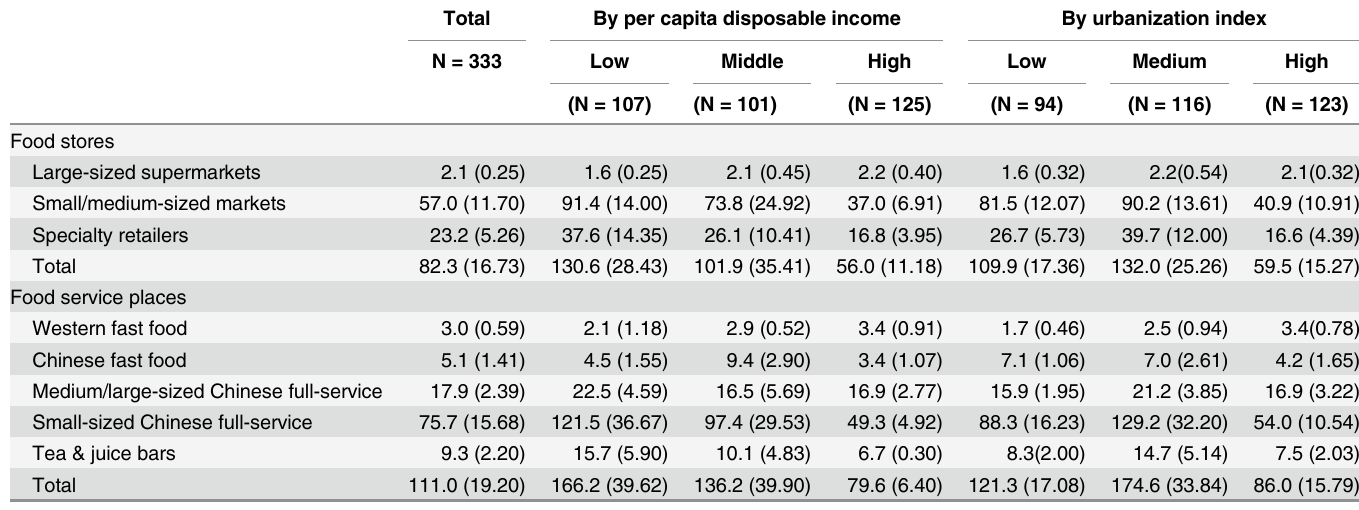
Table 2. Numbers of food stores and food service places per 10000 population by city level of income and urbanization, mean (SE) * .